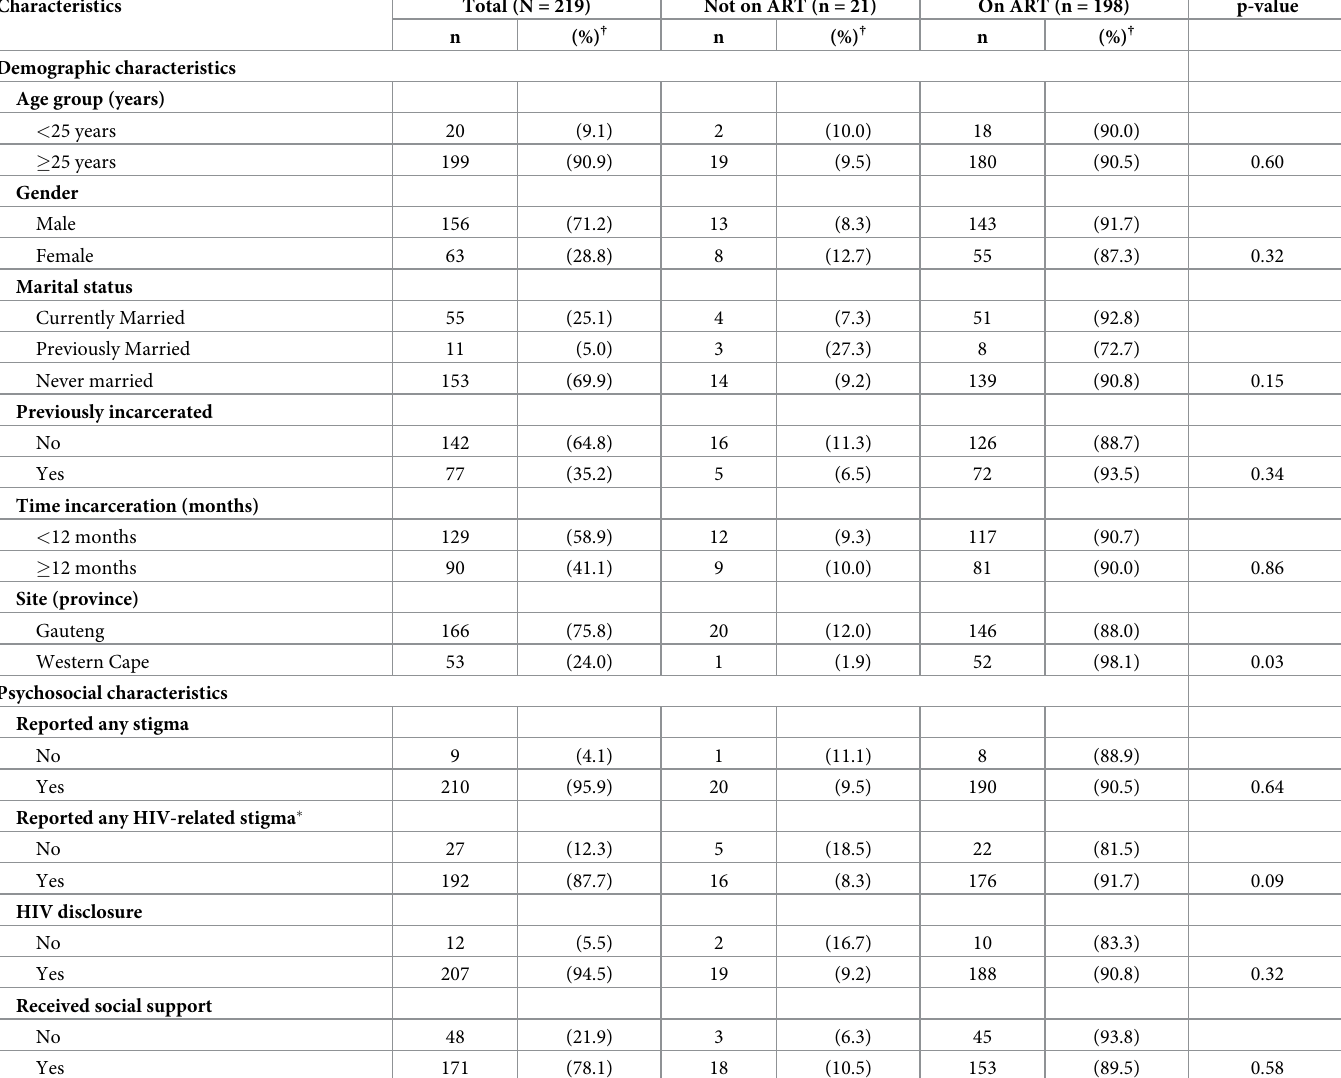
Table 1. Socio-demographic characteristics of TasP study participants who completed the psychosocial survey 6-months post-enrolment (N = 219) at selected cor- rectional facilities in, South Africa (2016–2018) by ART uptake.